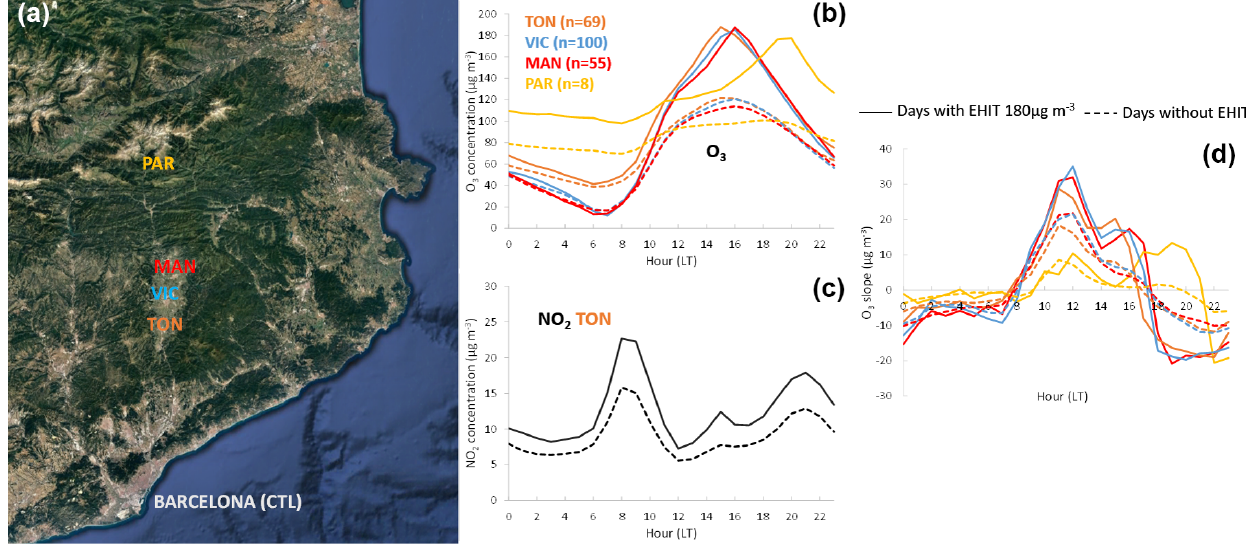
Figure 11. Average hourly O 3 concentrations for all days with EHIT records and those without for Tona (TON), Vic (VIC), Manlleu (MAN) and Pardines (PAR) air quality monitoring stations, (b) as well as for the NO 2 levels at TON (c) . Average hourly increments of O 3 concentrations for all days with and without EHIT records (d) ; in all cases for June–August